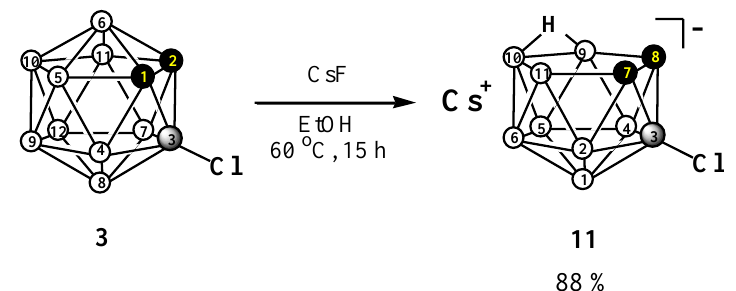
Figure 2. Crystal packing fragment of 3,6-Cl 2 -1,2-C 2 B 10 H 10 . The Cl ··· Cl contacts are shown by dashed lines.